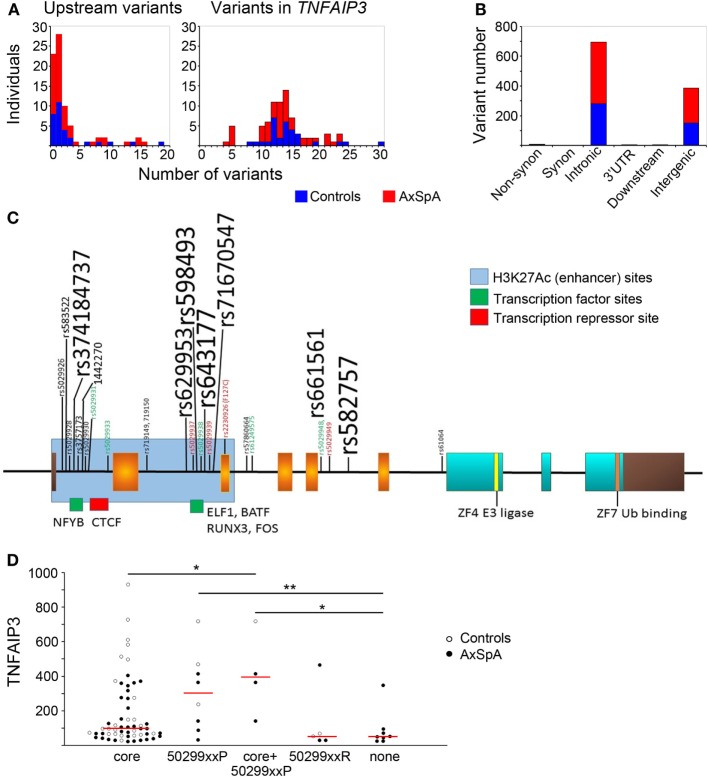
Distribution of variants within and upstream of TNFAIP3 and association with expression. TNFAIP3 exons and introns as well as putative regulatory regions (including the upstream promoter region) were sequenced by next-generation sequencing. (A) Numbers of axial spondyloarthritis (AxSpA) subjects (red bars) and healthy controls (blue bars) with specified numbers of upstream (left) or TNFAIP3 variants (right). (B) Distribution of variants within the TNFAIP3 gene according to functional region. (C) Variant map: exons encoding the OTU domain are in orange, zinc fingers in aqua and non-coding regions are brown. Approximate sites of H3K27Ac histone marks (blue region) and transcription factor-binding sites (green and red) are as described at http://genome.ucsc.edu. Location of rs-numbered variants present in at least 4 of 80 subjects are depicted. Variant font sizes correlate with number of subjects with the variant. Subjects were assessed as “low” expressers if ≤25th percentile of controls. Red font refers to variants where at least 2/3 subjects had low tumor necrosis factor alpha-induced protein 3 (TNFAIP3) expression and green font to <17% of subjects having low TNFAIP3 expression. (D) The groups of variants include subjects with common “core” variants, those with “protective” variants (“50299xxP”) associated with more moderate-high expression, a third group with 502xxP and core variants, those with “risk” variants (“50299xxR”) associated with lower expression, and a last group with none of these variants (“none”). One individual with both protective and risk variants was excluded from the analysis related to potentially conflicting effects. AxSpA subjects are in filled circles and controls in open circles. Red lines denote median expression in variant groups (*p ≤ 0.05, **p ≤ 0.005).